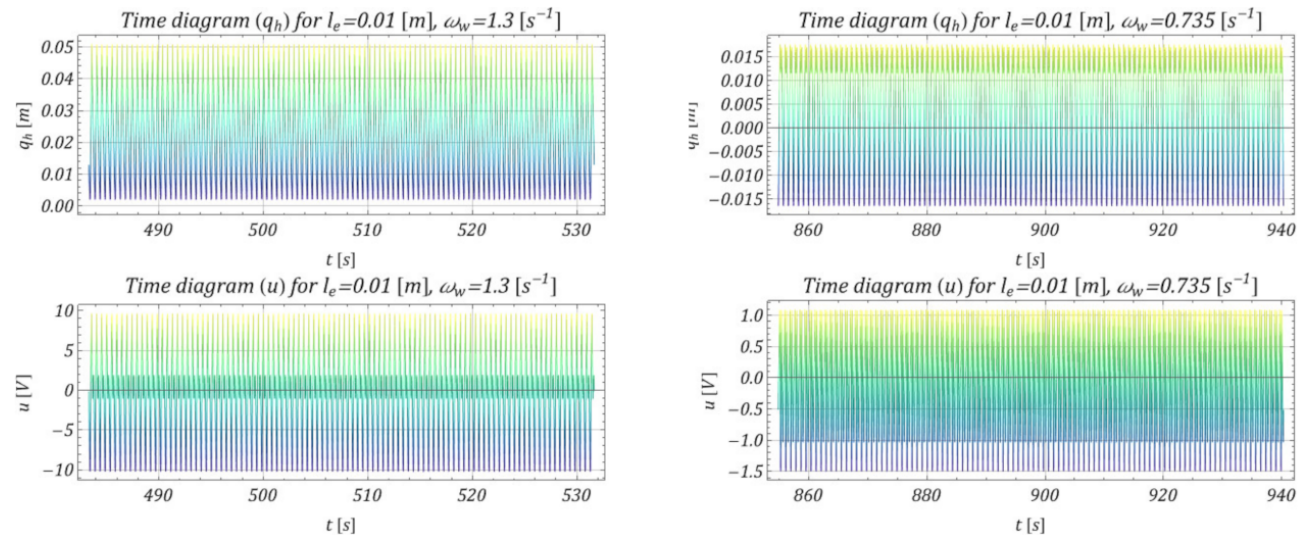
Figure 12. Voltage output and displacement time series related to selected solutions—sample periodic solutions for l e = 0.01 m.